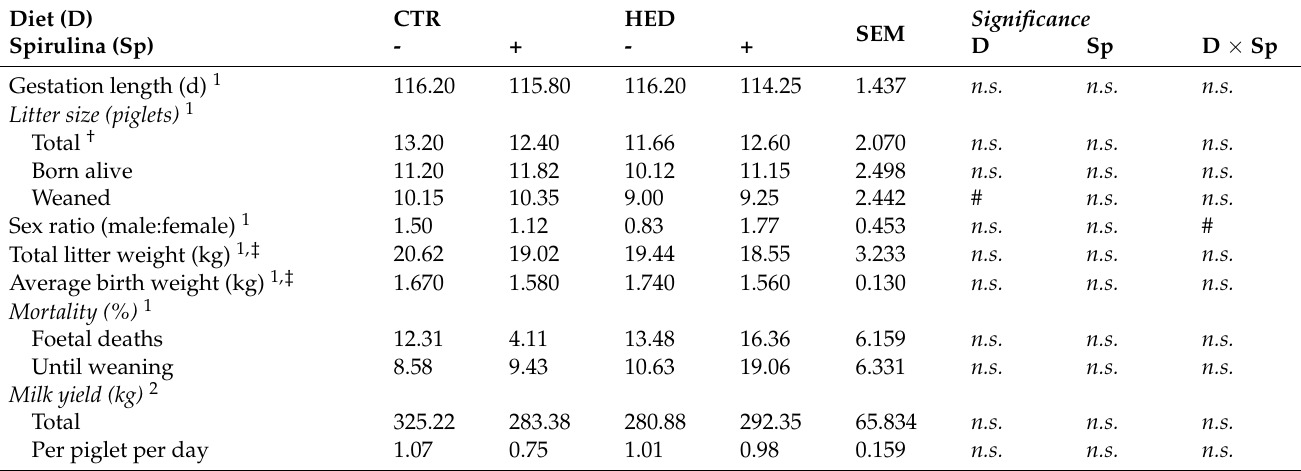
Table 2. Effect of a high-energy diet and spirulina supplementation on reproductive and lactational performance of the sows.